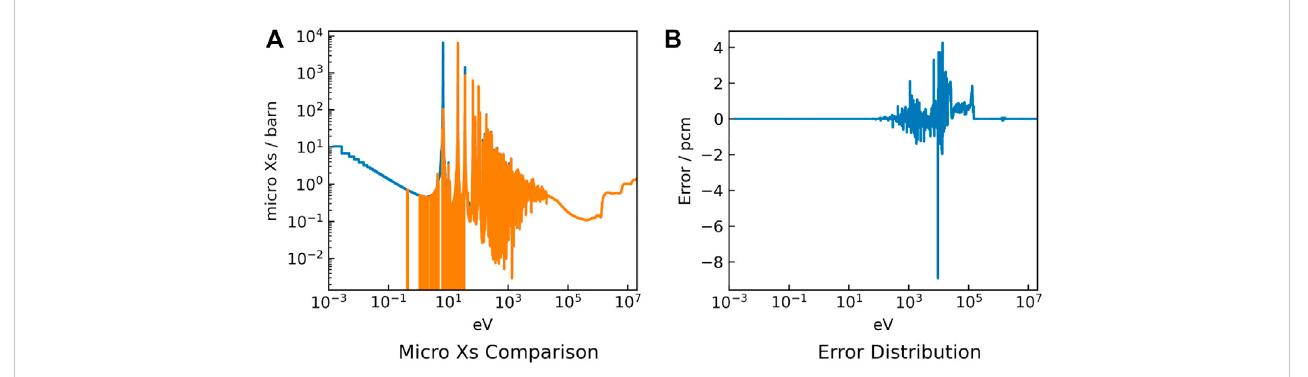
FIGURE 12 238 U absorption cross section results (A) and errors (B) for the UO 2 problem with fast